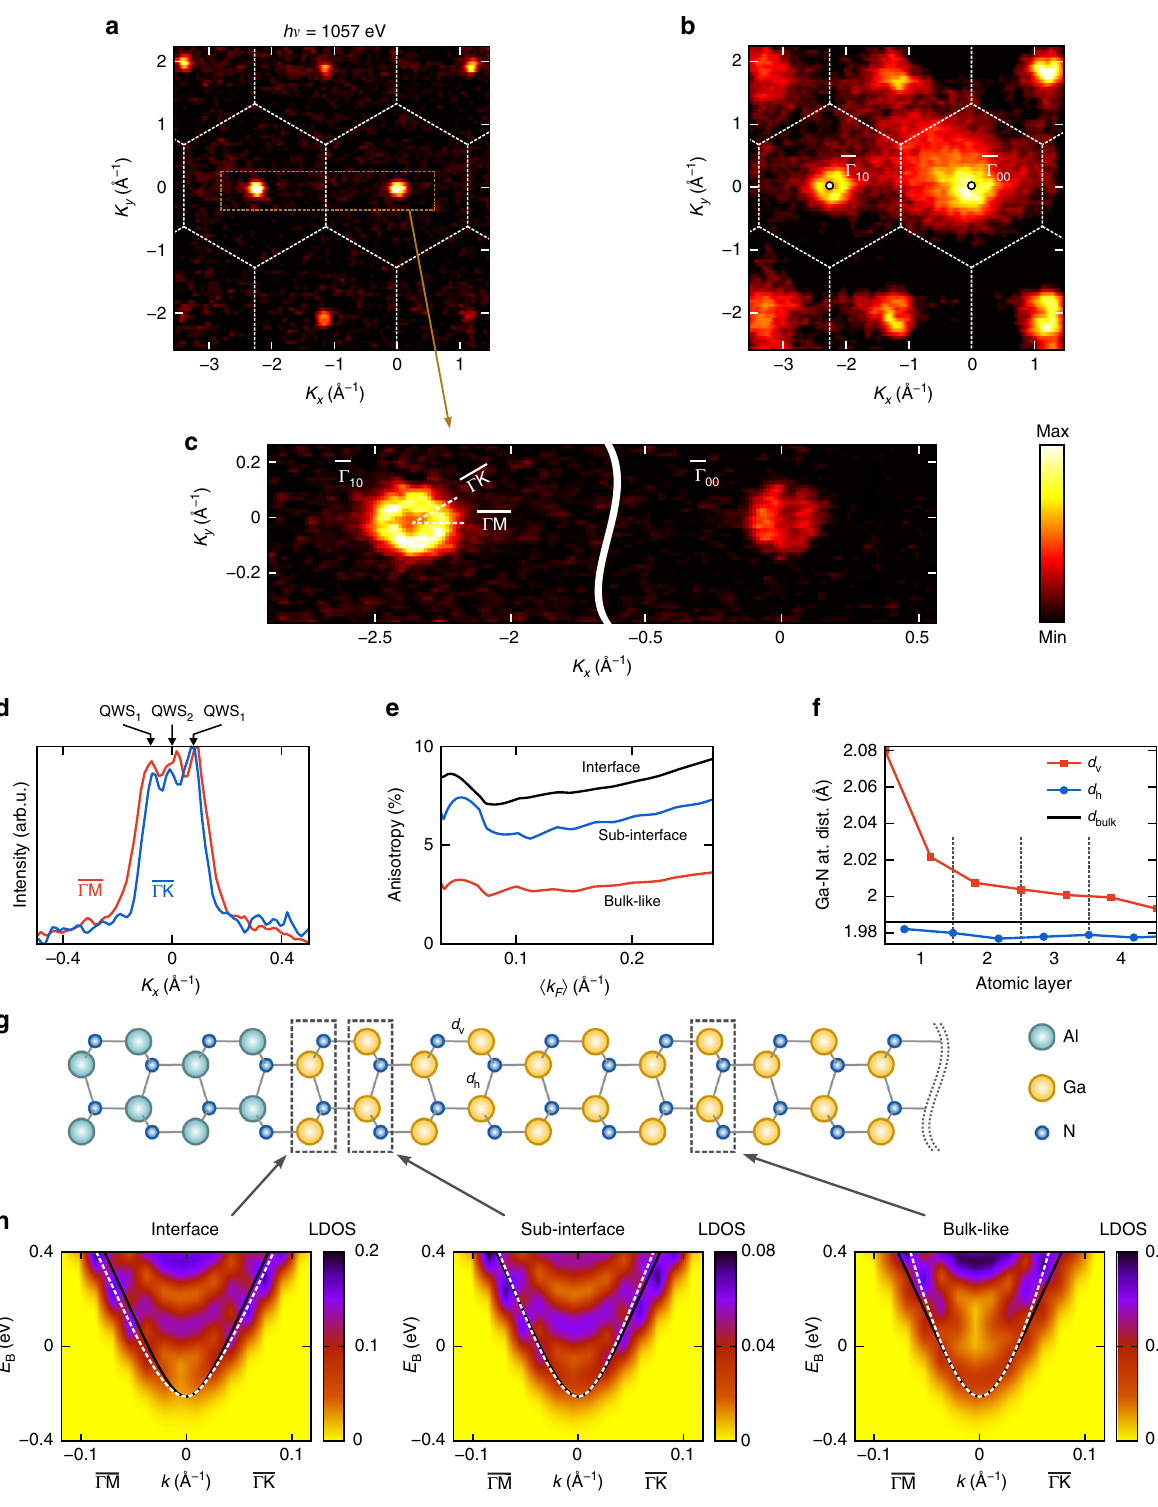
Fig. 2 FS formed by the buried 2DEG. a Experimental FS formed by the 2DEG in comparison with b iso- E B surface of the VB near the VBM. The FS appears as narrow electron pockets centered at the around the Γ -points, consistent with the CBM-derived character of the 2DEG. Both VB and FS maps re fl ect the C 6v symmetry of the GaN crystal lattice. c FS along the Γ 00 (cid:2) Γ 10 line acquired with high energy and angle resolution. d MDCs of the Fermi intensity around the Γ 10 -point (derived from the high-statistics data in Fig. 4) identifying the tiny QWS 2 and anisotropy of the QWS 1 between the 12%. e Calculated A F of QWS 1 between Γ M and Γ K as a function of band fi lling characterized by< k F >, for bulk GaN and for various heterostructure layers. f Relaxation of the Ga-N bond length as a function of depth and g u.c. used in the slab calculations. h k // -resolved LDOS for various heterostructure layers near the CBM with E F adjusted to the experimental< k F >and superimposed with the corresponding bulk E ( k ) along Г M and Г K (black lines). The QWS 1 dispersion (white dashed in the bottom of the LDOS continuum) in the top GaN layers shows an asymmetry related to the interfacial atomic